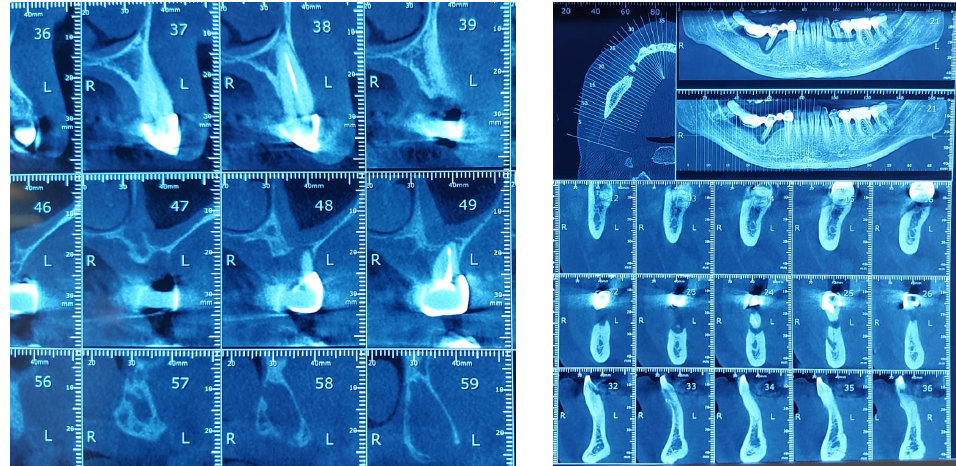
Figure 7. Bone Changes in periodontal disease through CBCT. ( a ) Maxilla CBCT- Bone Changes in periodontal disease; ( b ) CBCT mandible- Bone Changes in periodontal disease.